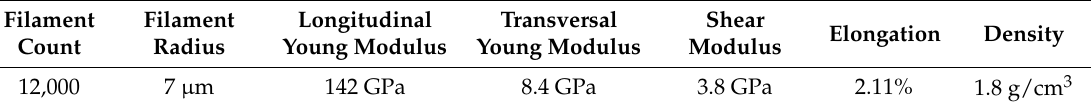
Table 2. Mechanical properties of the multidirectional carbon fiber composite laminate.